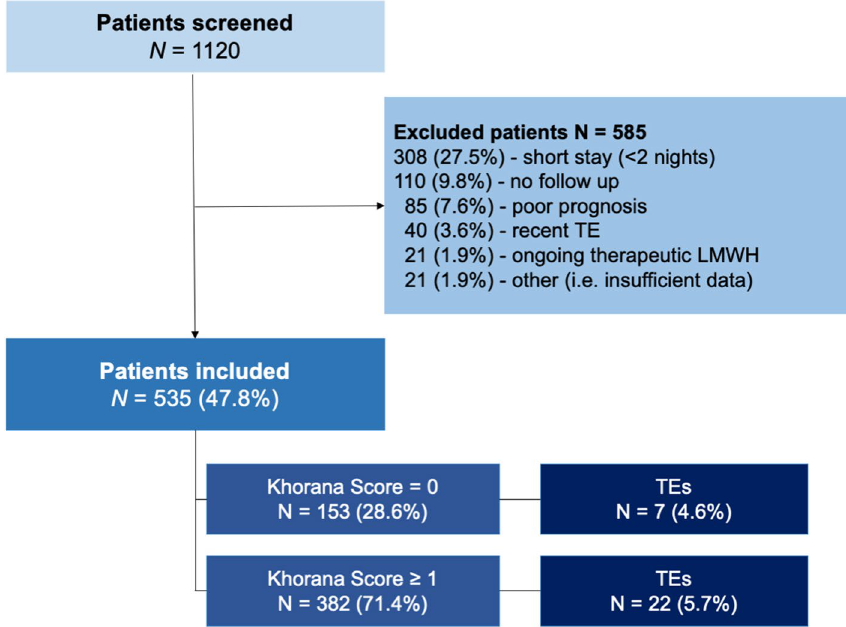
Figure 1. Study flowchart. TE thromboembolic event, LMWH low molecular weight